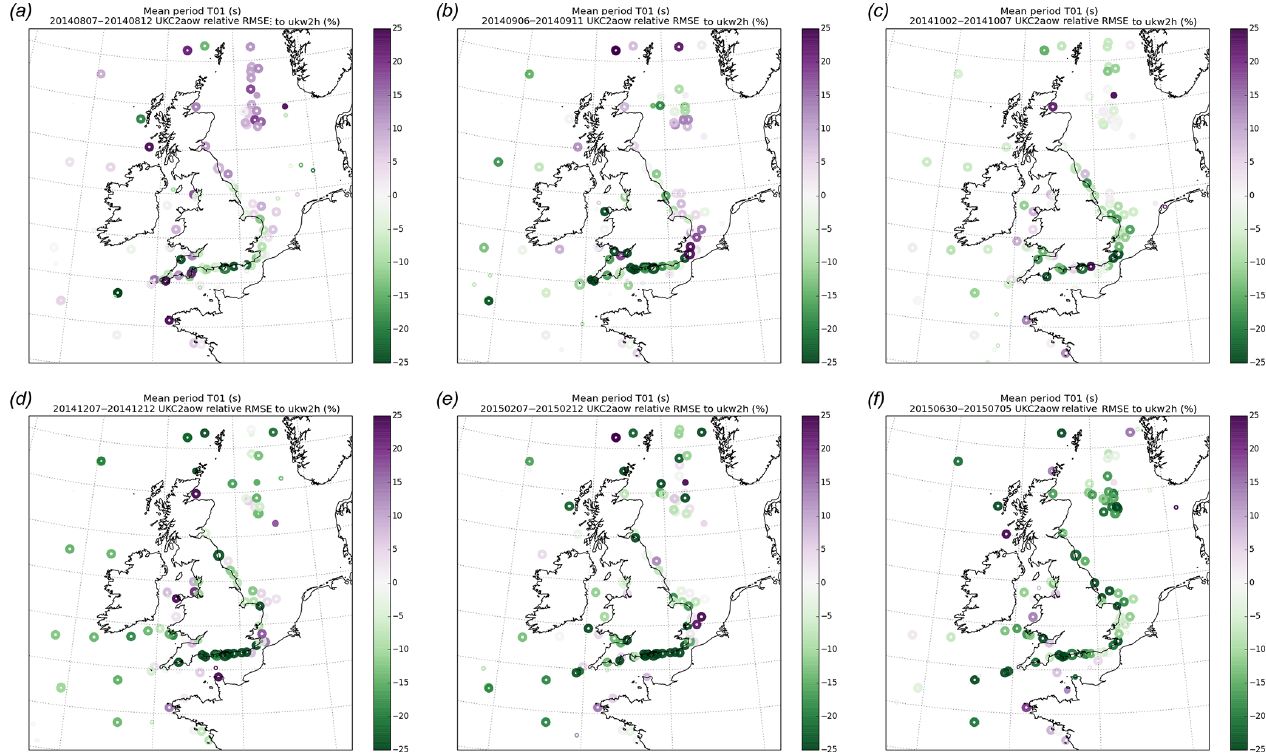
Figure 14. Differences in case study wave model RMSE statistics for wave mean period, comparing statistics computed for the fully coupled UKC2aow simulation as a % difference relative to the wave-only UKW2h runs with high-resolution wind forcing. Green sites indicate an overall reduction in RMSE relative to the control. Results are shown for 5-day case study periods in (a) August 2014, (b) September 2014, (c) October 2014, (d) December 2014, (e) February 2015 and (f) July 2015. RMSE statistics are computed comparing UKC2aow and UKW2h model outputs with in situ observations. Note that only an inner section of the domain is presented for